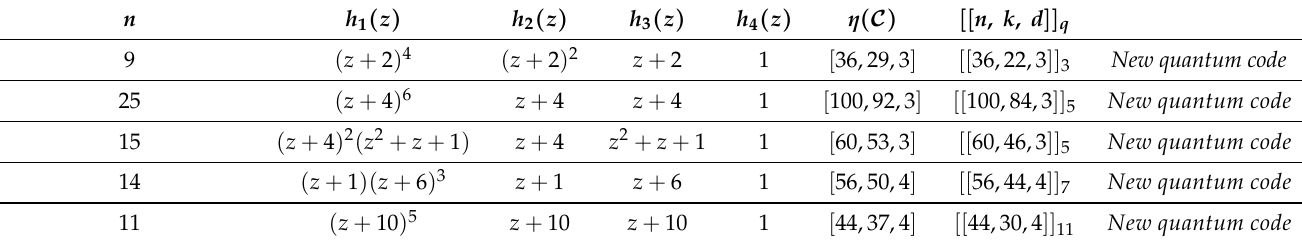
Table 2. New quantum codes from cyclic codes over R .